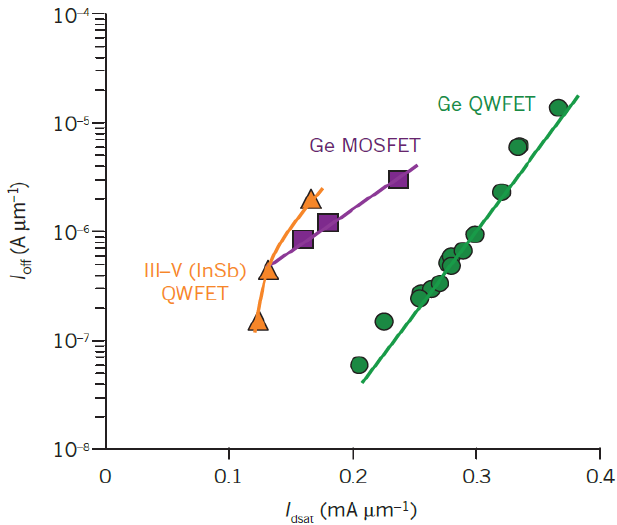
vs. I ) of 65 nm Ge pMOSFET, 40 nm off dsat